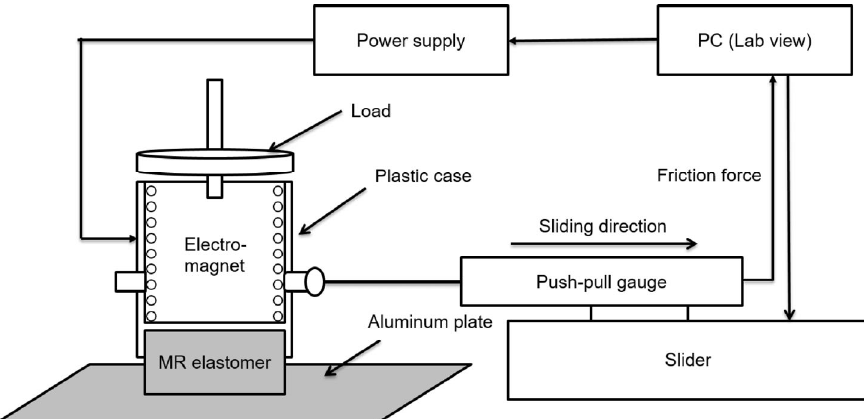
Fig. 3 Schematic diagram of stick-slip